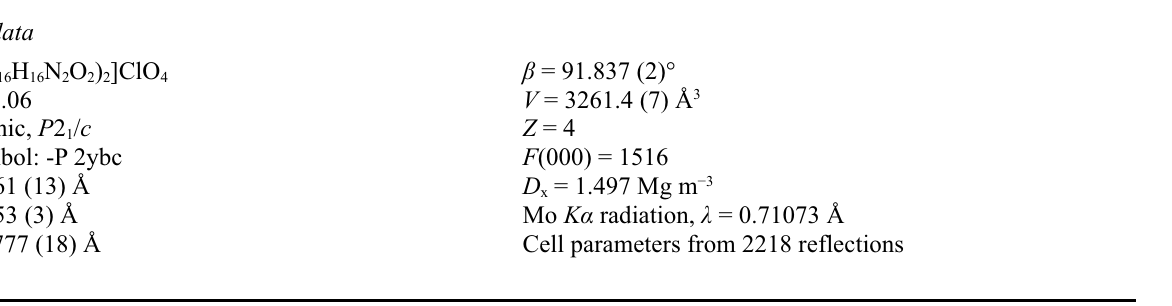
Part of the crystal structure showing intermolecular π ··· π stacking indicated by dashed lines. All H atoms and perchlorate anions have been omitted for